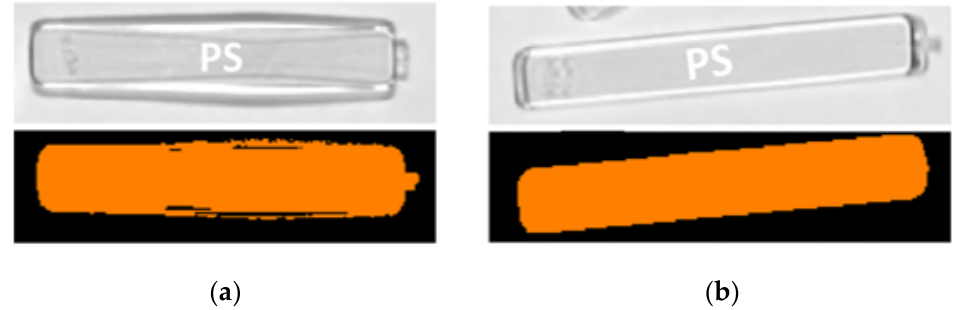
Figure 5. Influence of shadow on the classification process. Here shadow occurs only on the neighboring area surrounding the object. ( a ) Classification of pixels values belonging to the class PS using spectral data. ( b ) Classification of pixels values belonging to the class PS after removal of the background.